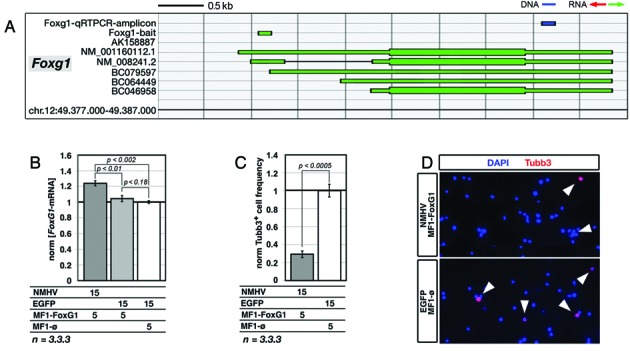
NMHV-mediated transactivation of Foxg1 in murine, embryonic cortico-cerebral precursors and its biological correlate. (A) Schematics of the murine Foxg1 locus, with natural transcripts, artificial baits and diagnostic amplicons used in this study. Nucleotide numbering refers to UCSC-mm10. Color code: blu, DNA; green, sense-oriented RNA. (B)Foxg1-mRNA upregulation in precursors infected by NMHV- and MF1-Foxg1-encoding lentivectors. EGFP and MF1-øviruses were used as controls. Results were normalized against Gapdh and further normalized against the EGFP/MF1-øcombination. (C) Reduced frequency of cells immunopositive for the neuron-specific Tubb3 marker, in cultures of NMHV/MF1-Foxg1-overexpressing precursors. (D) Examples of aTubb3 immuno-fluorescences referred to in (C). In all cases (B–D) time-frame of the experiments as well as representation of moi's and statistical parameters are as in Figure 3.